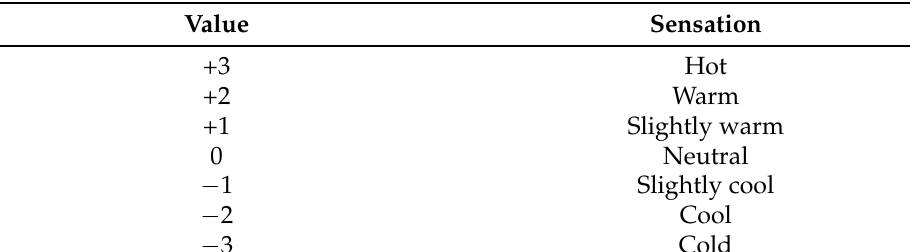
Table 1. Thermal Sensation Scale.